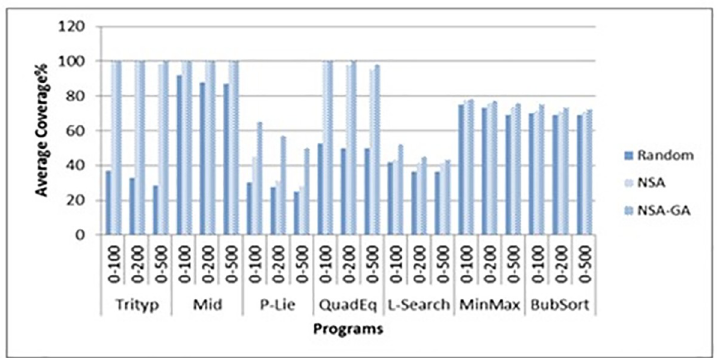
Fig 13. Comparison between AC of random testing, NSA and NSA-GA methods using different ranges for float input data.